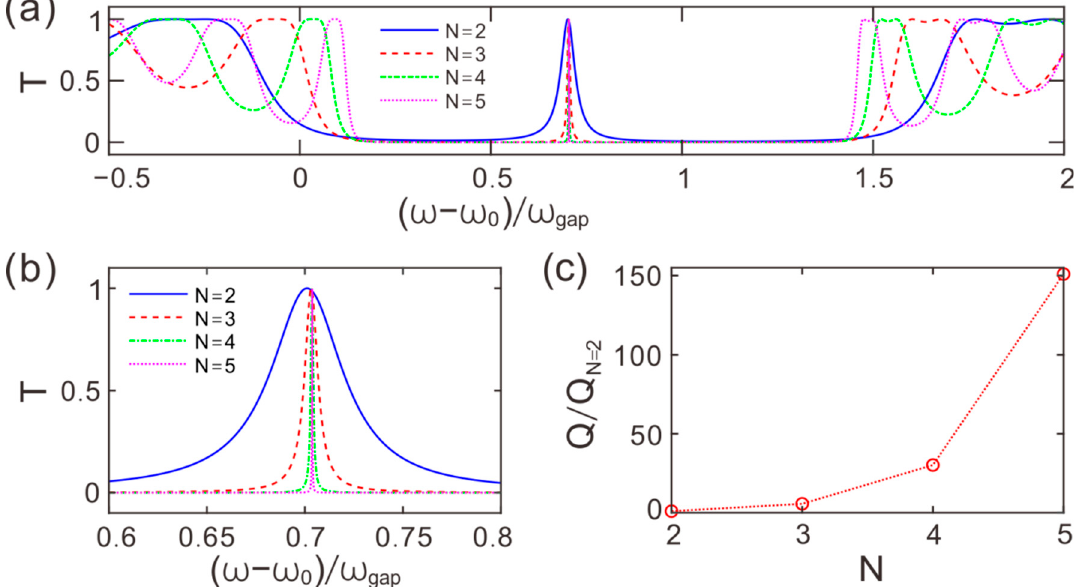
Figure 5. ( a ) Transmission spectra for different periodic numbers of photonic crystal N . ( b ) Trans ‐ mitted peaks for different N . ( c ) Quality factor of resonant cavity changing with N . Incident angle of light beam is set as θ = 45°.